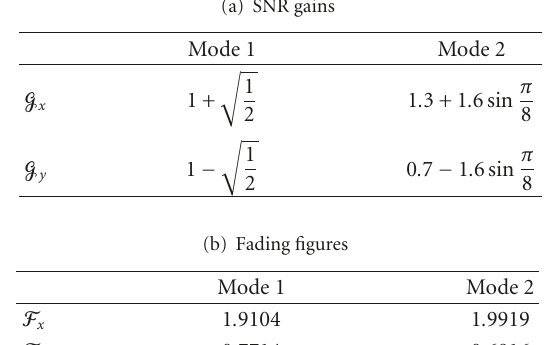
Table 1: SNR gains and fading figures in case of CL TD mode 1 and 2.